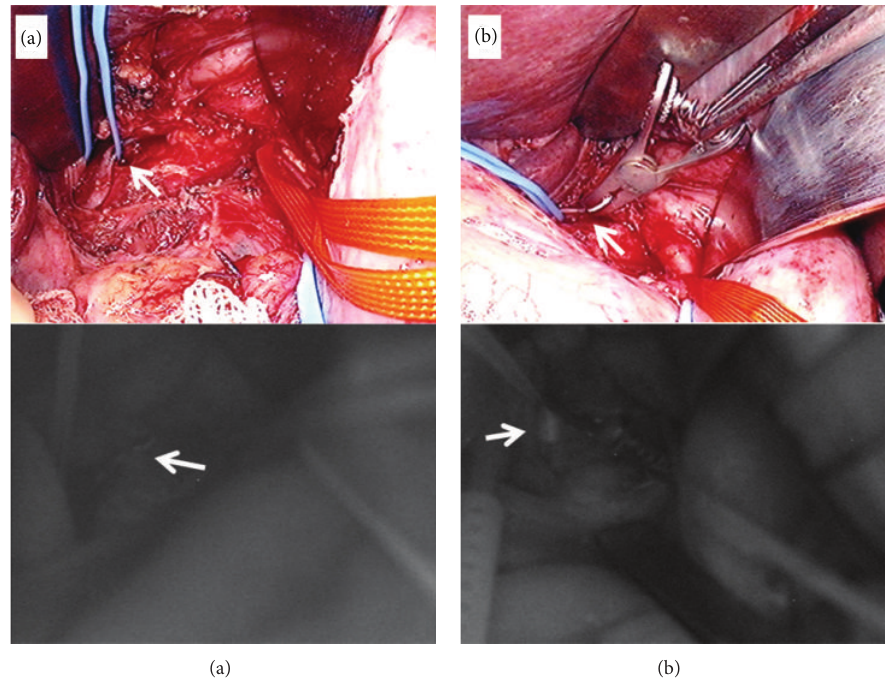
Figure 2: Intraoperative view and indocyanine green fluorescence lymphography. (a) The thoracic duct is seen on the right side of gastric tube (arrow). (b) A bulldog clamp is placed around the thoracic duct and the dilated thoracic duct is confirmed